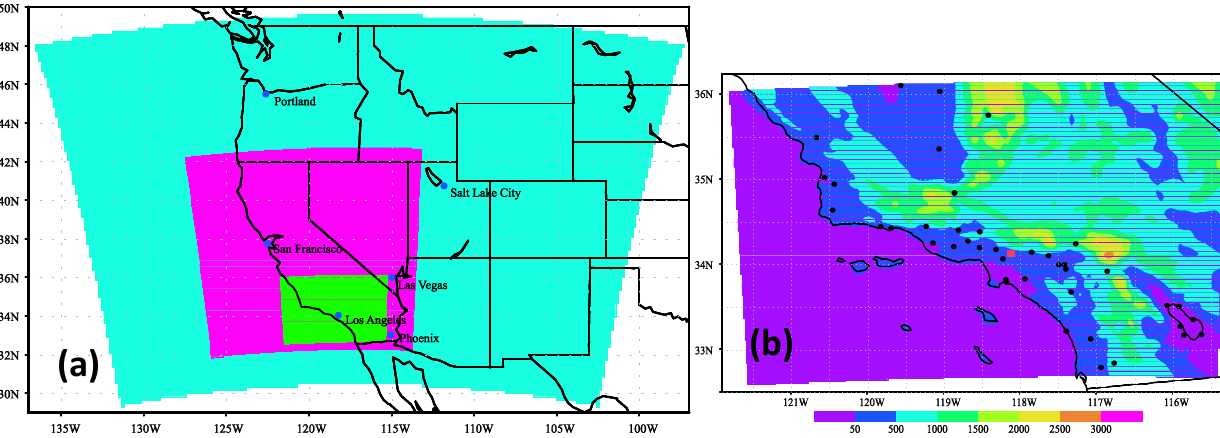
Fig. 1. Model domains, topography and location of observations. The three nested model domains are shown in the left panel. The right panel Figure 1. Model domains, topography and location of observations. The three nested gives the topography in the small domain along with the locations of the 42 PM 2 . 5 monitoring stations (black dots) operated by the California Air Resources Board (ARB) and one super observing station (red square), which was located on the campus of the California Institute of Technology and collected speciated aerosol concentrations during the CalNex 2010 field model domains are shown in the left panel. The right panel gives the topography in